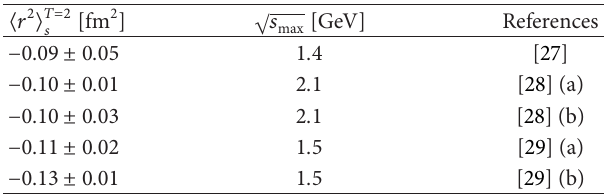
Table 1: Lorentz scalar isospin 𝑇 = 2 mean square radius of the pion, as determined using (43). The phase-shift analyses of [27–29] are used; (a) and (b) denote nonequivalent datasets of scattering isthemaximum energy up towhich thephaseanalysis phases. √𝑠 max is